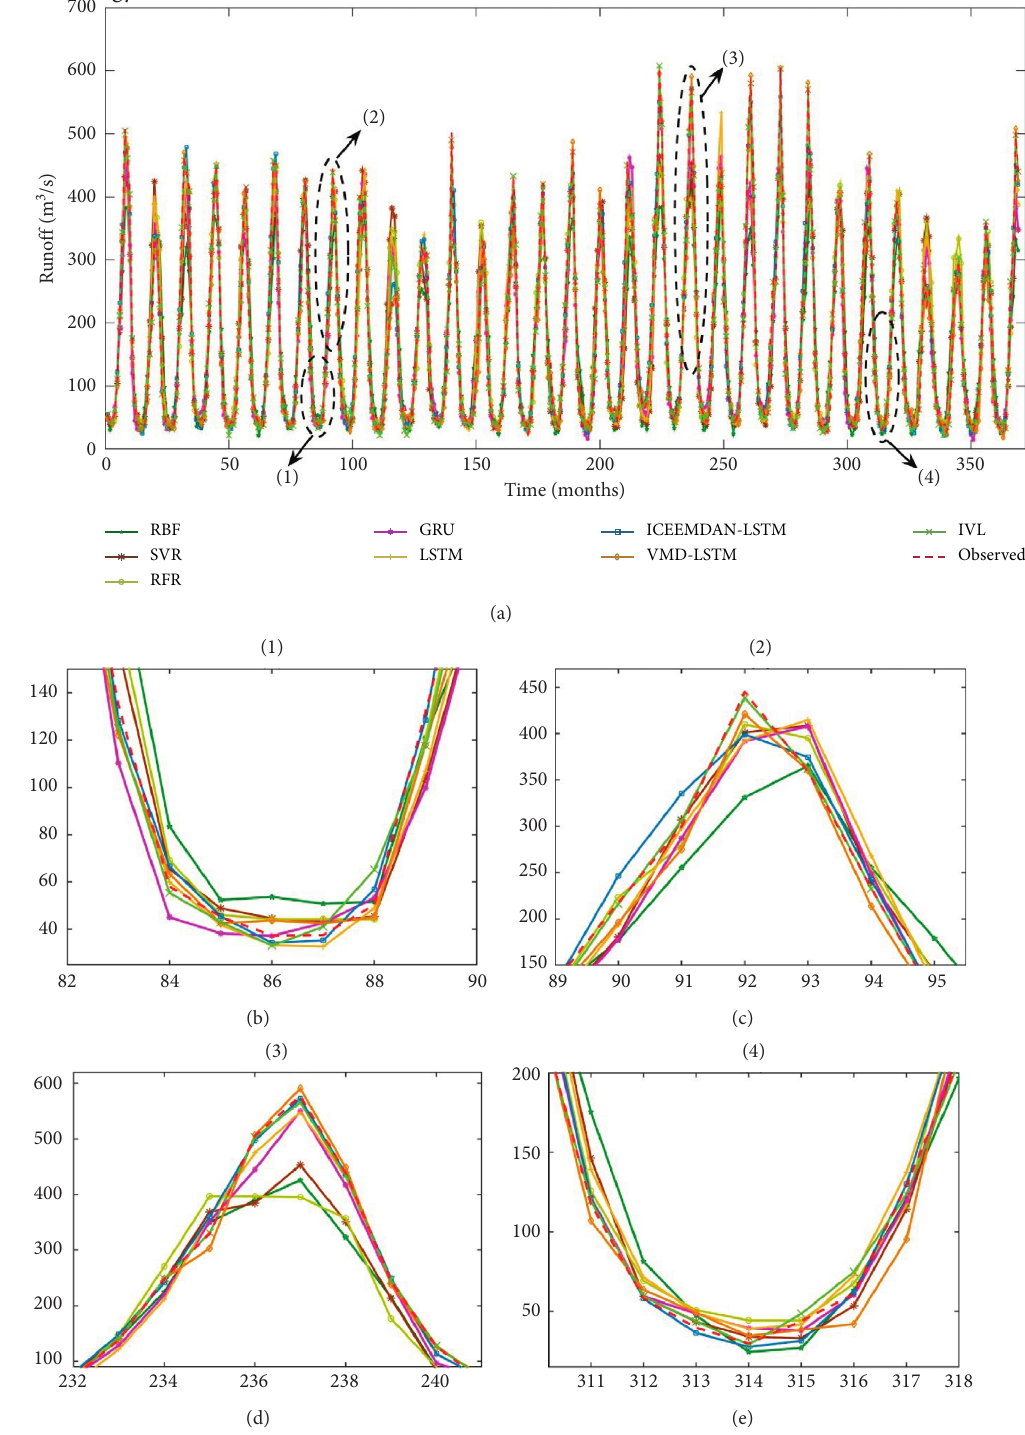
Figure 9: Observed and predicted streamflow using RBF, SVR, RFR, GRU, LSTM, ICEEMDAN-LSTM, VMD-LSTM, and IVL models during the training